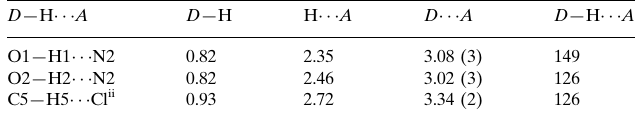
Hydrogen-bond geometry (A˚ , (cid:2)